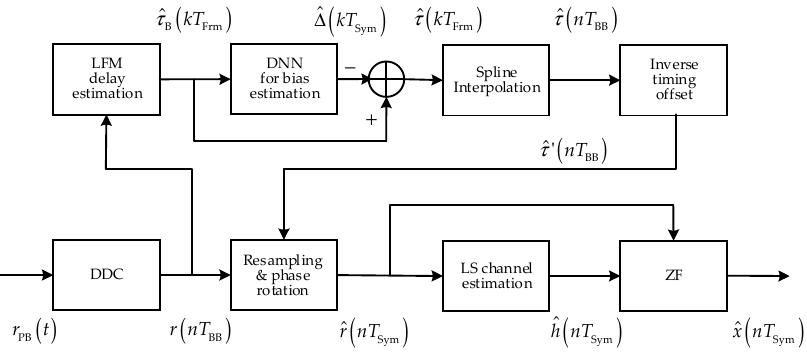
Figure 2. Receiver structure. LFM, linear frequency modulation; DDC, digital down converter; LS, least-squared; ZF, zero forcing equalization.